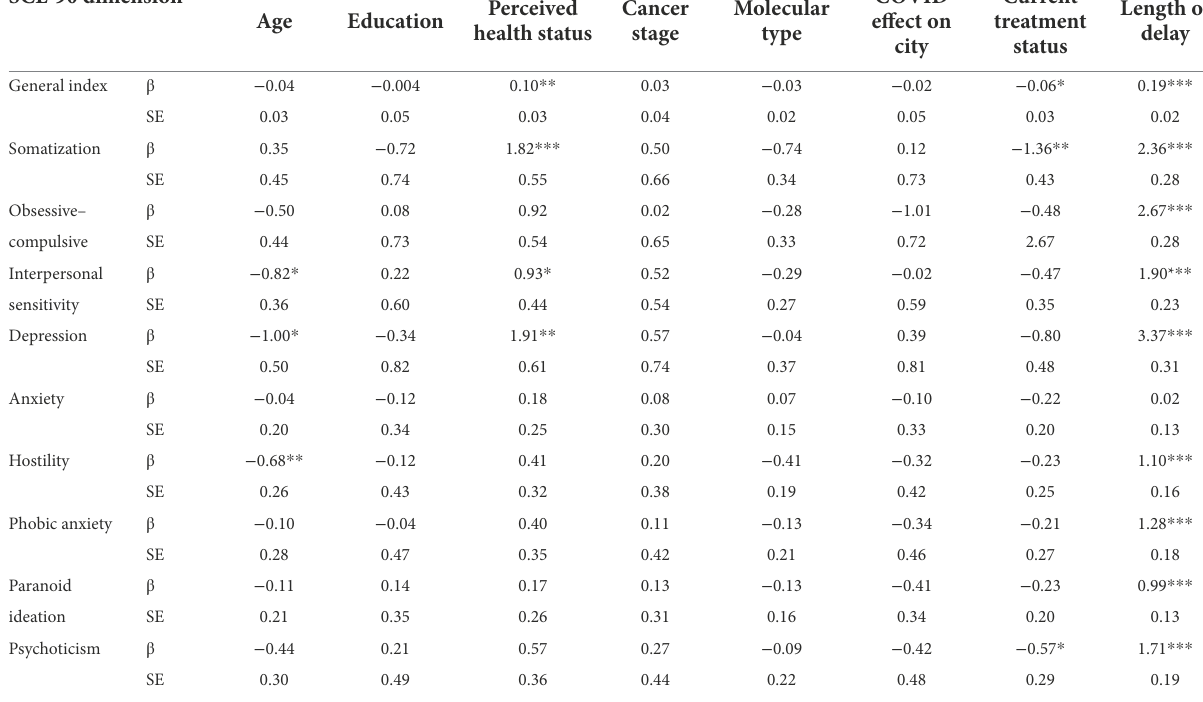
TABLE 2 Results of multiple regression